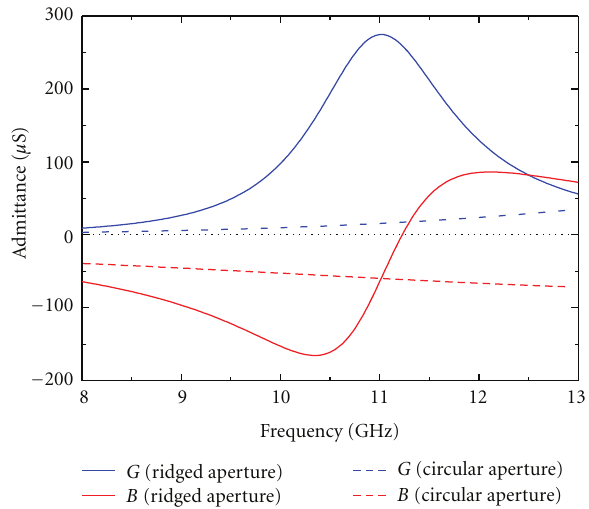
Figure 4: Admittance (conductance G and susceptance B ) for ridged circular aperture and original host circular aperture with diameter of